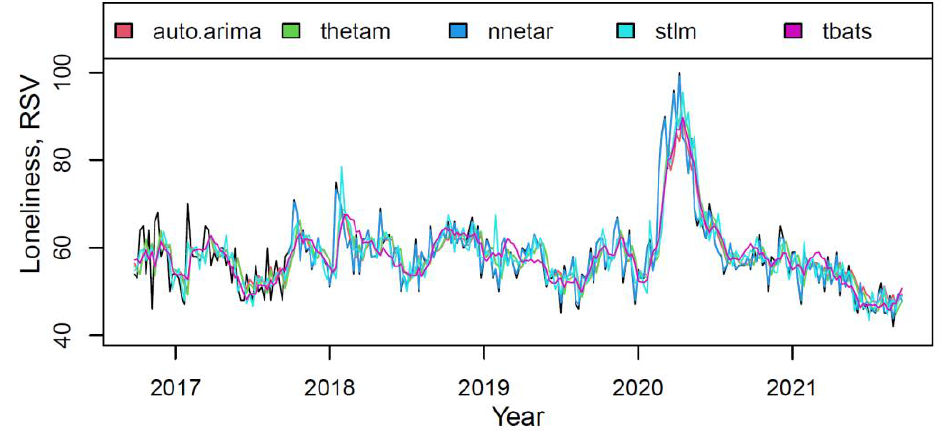
Figure 5. The actual (black) and fitted values of each component of the M3 hybrid model.